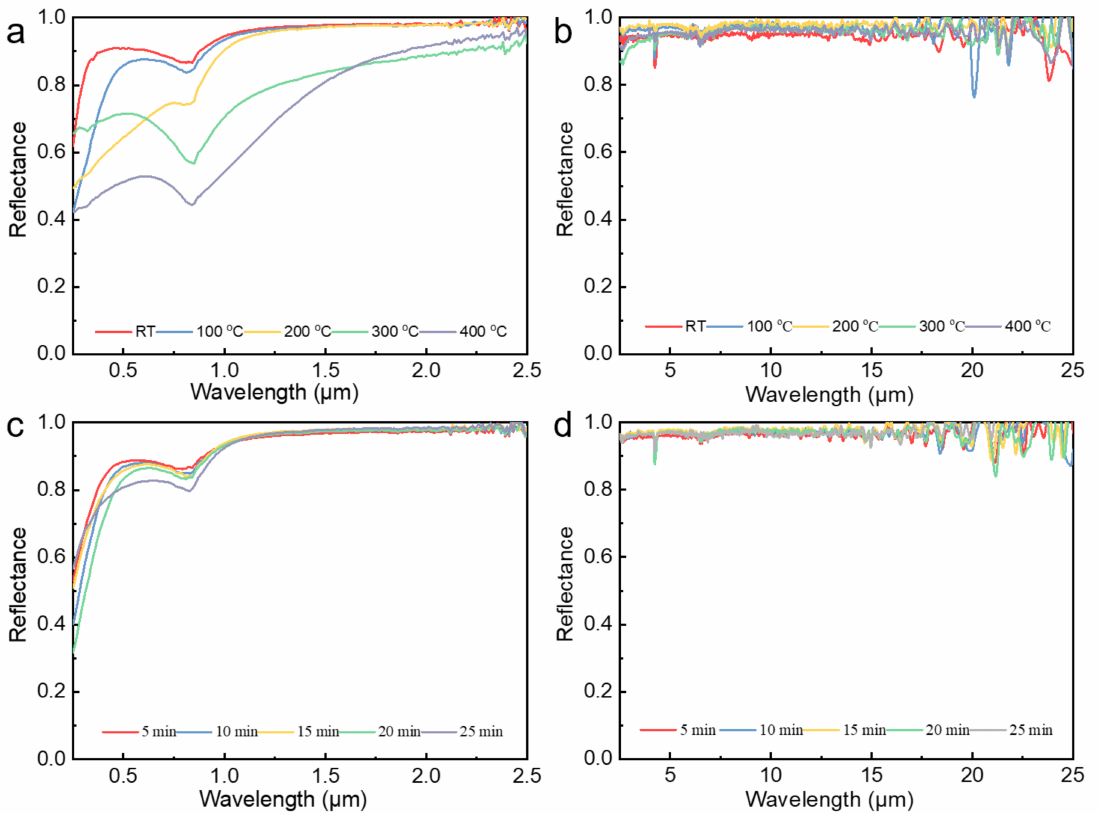
Figure 5. ( a ) UV-VIS-IR reflectance spectra and ( b ) NIR/MIR-IR reflectance spectra of the Al films at different deposition temperatures. ( c ) UV-VIS-IR reflectance spectra and ( d ) NIR/MIR-IR reflectance spectra of the Al films at different deposition